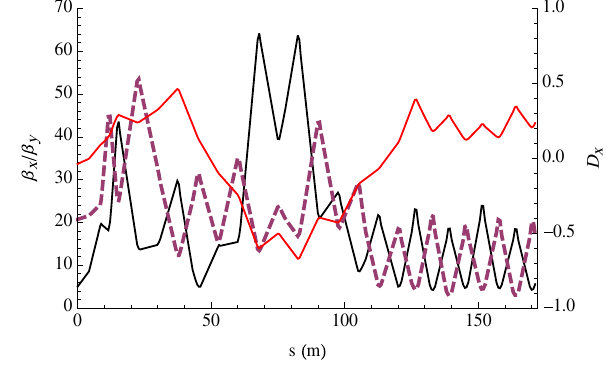
FIG. 2. β (black solid trace), β (dashed trace) and the x y dispersion function D (red trace) plotted from the midpoint x of IP6 to the first arc